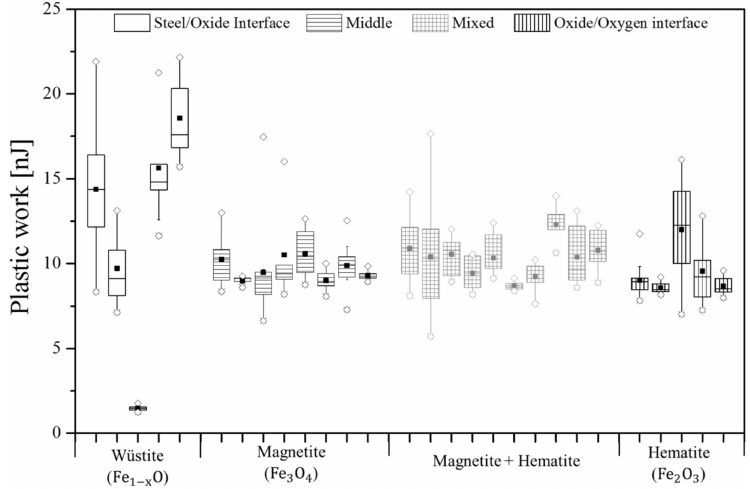
Figure 19. Plastic work of the wüstite, magnetite, and hematite